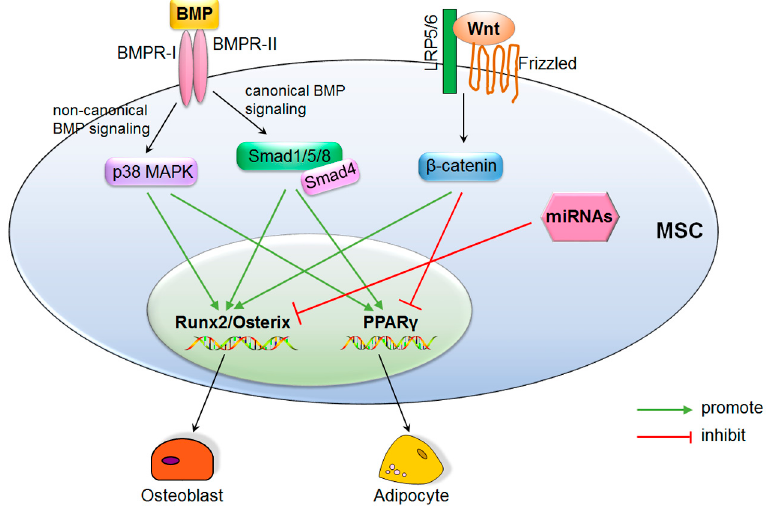
Figure 2. Integration of bone morphogenic protein (BMP) and wingless and int-1 (Wnt) signaling pathways, miRNAs, and key transcription factors in regulating osteoblast and adipocyte differentiation of MSCs. The BMP signaling, Wnt signaling, and miRNAs regulate osteoblast differentiation or adipocyte differentiation of MSCs by targeting key transcription factors such as runx2, osterix, or PPAR γ .